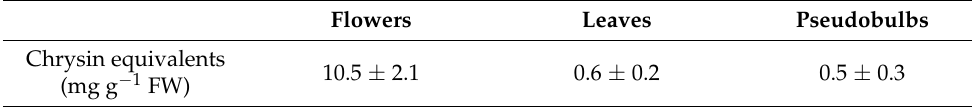
Table 2. Chrysin content in Oncidium sotoanum organs. FW = fresh weight. Flowers